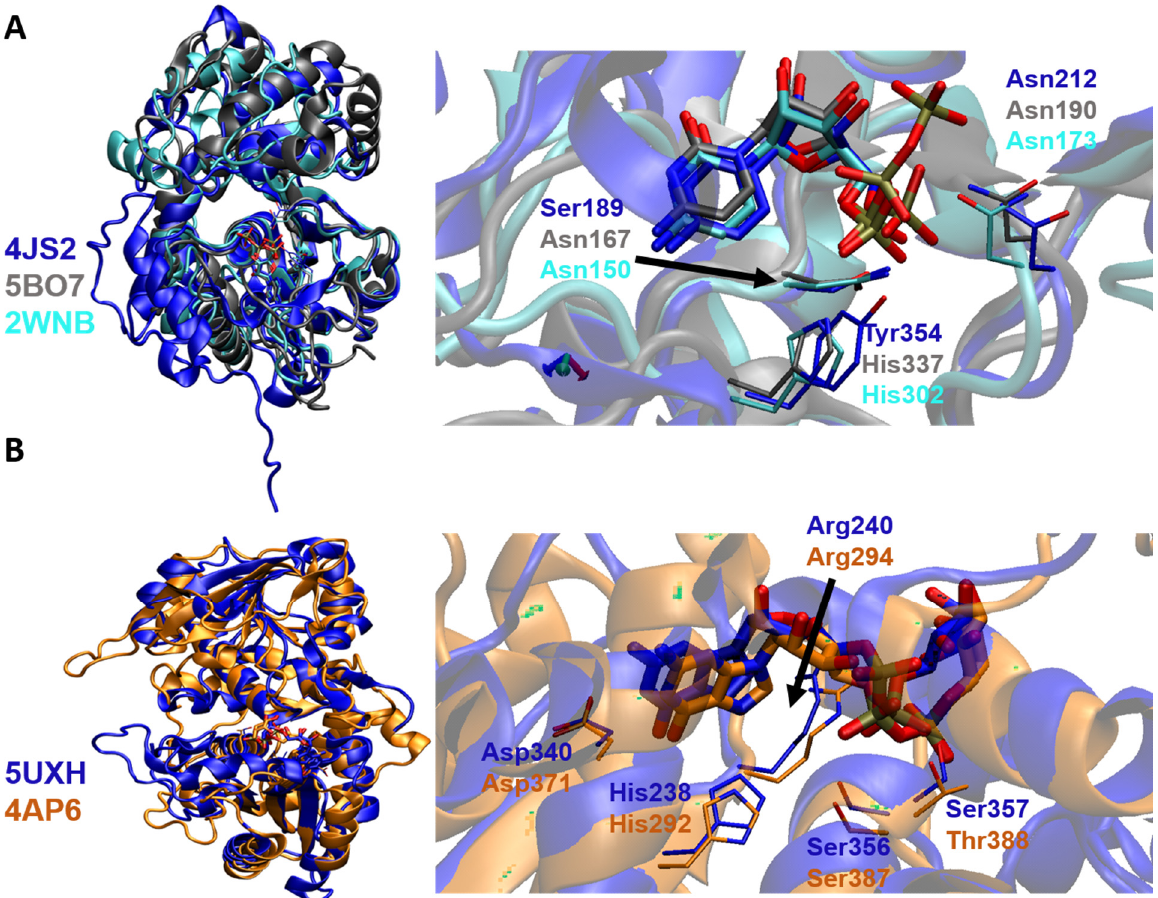
Figure 6. ( A ) Structural alignment of the protein backbone of three different sialyltransferases: Hs ST3GAL1 (cyan, PDB id: 2WNB), Hs ST6GAL1 (blue, PDB id: 4JS2), and Hs ST8SIA3 (gray, PDB id: 5BO6), highlighting the alignment of the donor CMP/CDP substrates and their surrounding residues shown in sticks. Zoomed views of the bound ligands with their interacting residues are displayed in the right panel. ( B ) Structural alignment of the protein backbone of the two FUT complexes. The ternary complex of Hs POFUT1 is shown in blue (PDB id: 5UXH) and Hs POFUT2 is shown in brown (PDB id: 4AP6), with the aligned GDP-fucose donor substrates and surrounding residues shown in sticks. Zoomed views of bound ligands with their interacting residues are displayed in the right panel.